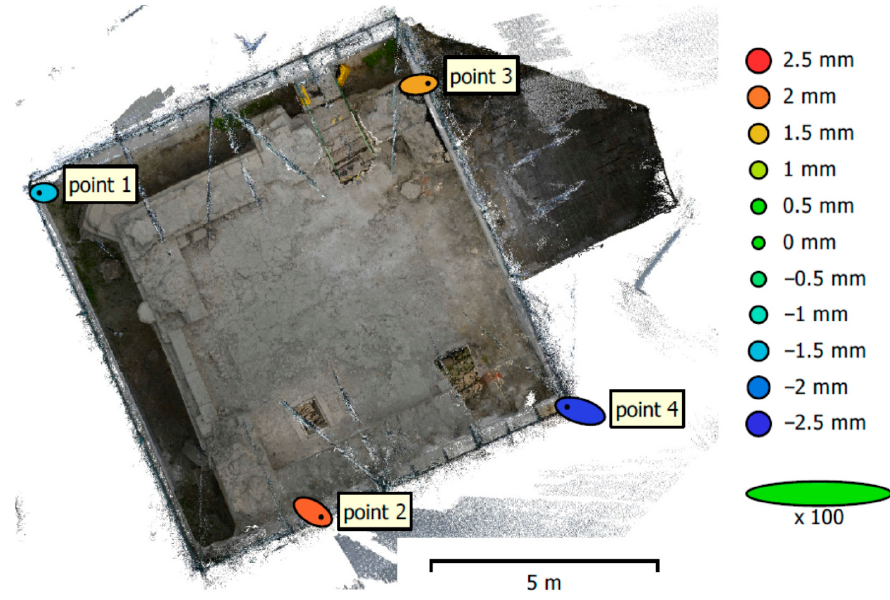
Figure 9. Positions of the identical points in the structures around the chapel (corners of concrete retaining walls and metal window frames). Z error is represented by ellipse color. X and Y errors are represented by ellipse shapes.